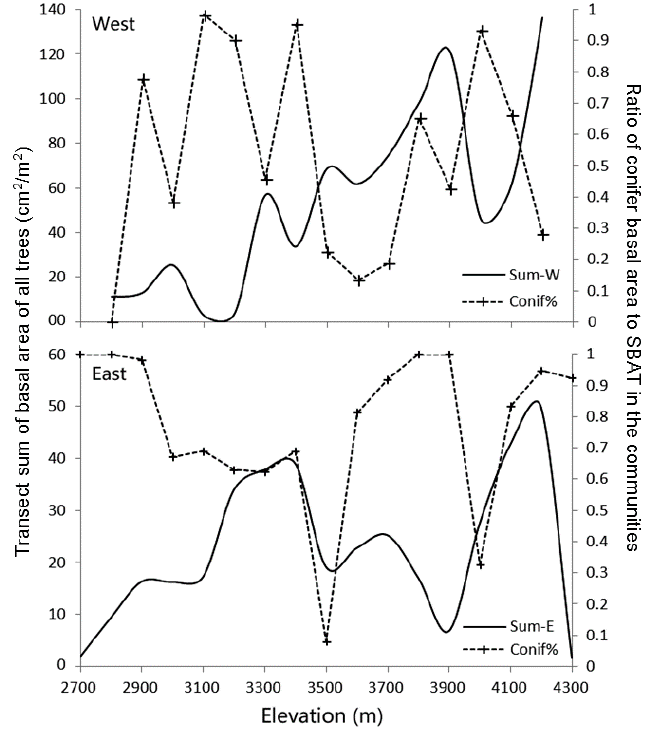
Figure 2. Elevation-related patterns of the transects: sum of basal area of all trees (SBAT, solid line) and the ratio of conifer basal area to SBAT in the communities (broken line with crosses) on western and eastern aspects of Baima Snow Mountain.